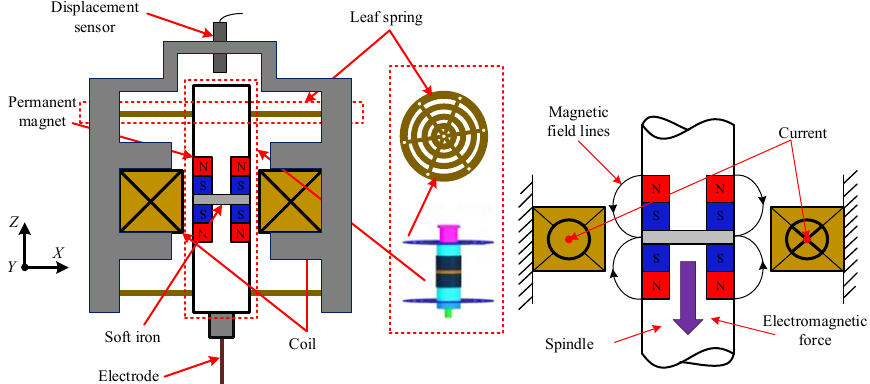
Figure 1. Structure of single-degree-of-freedom controllable magnetic actuator.